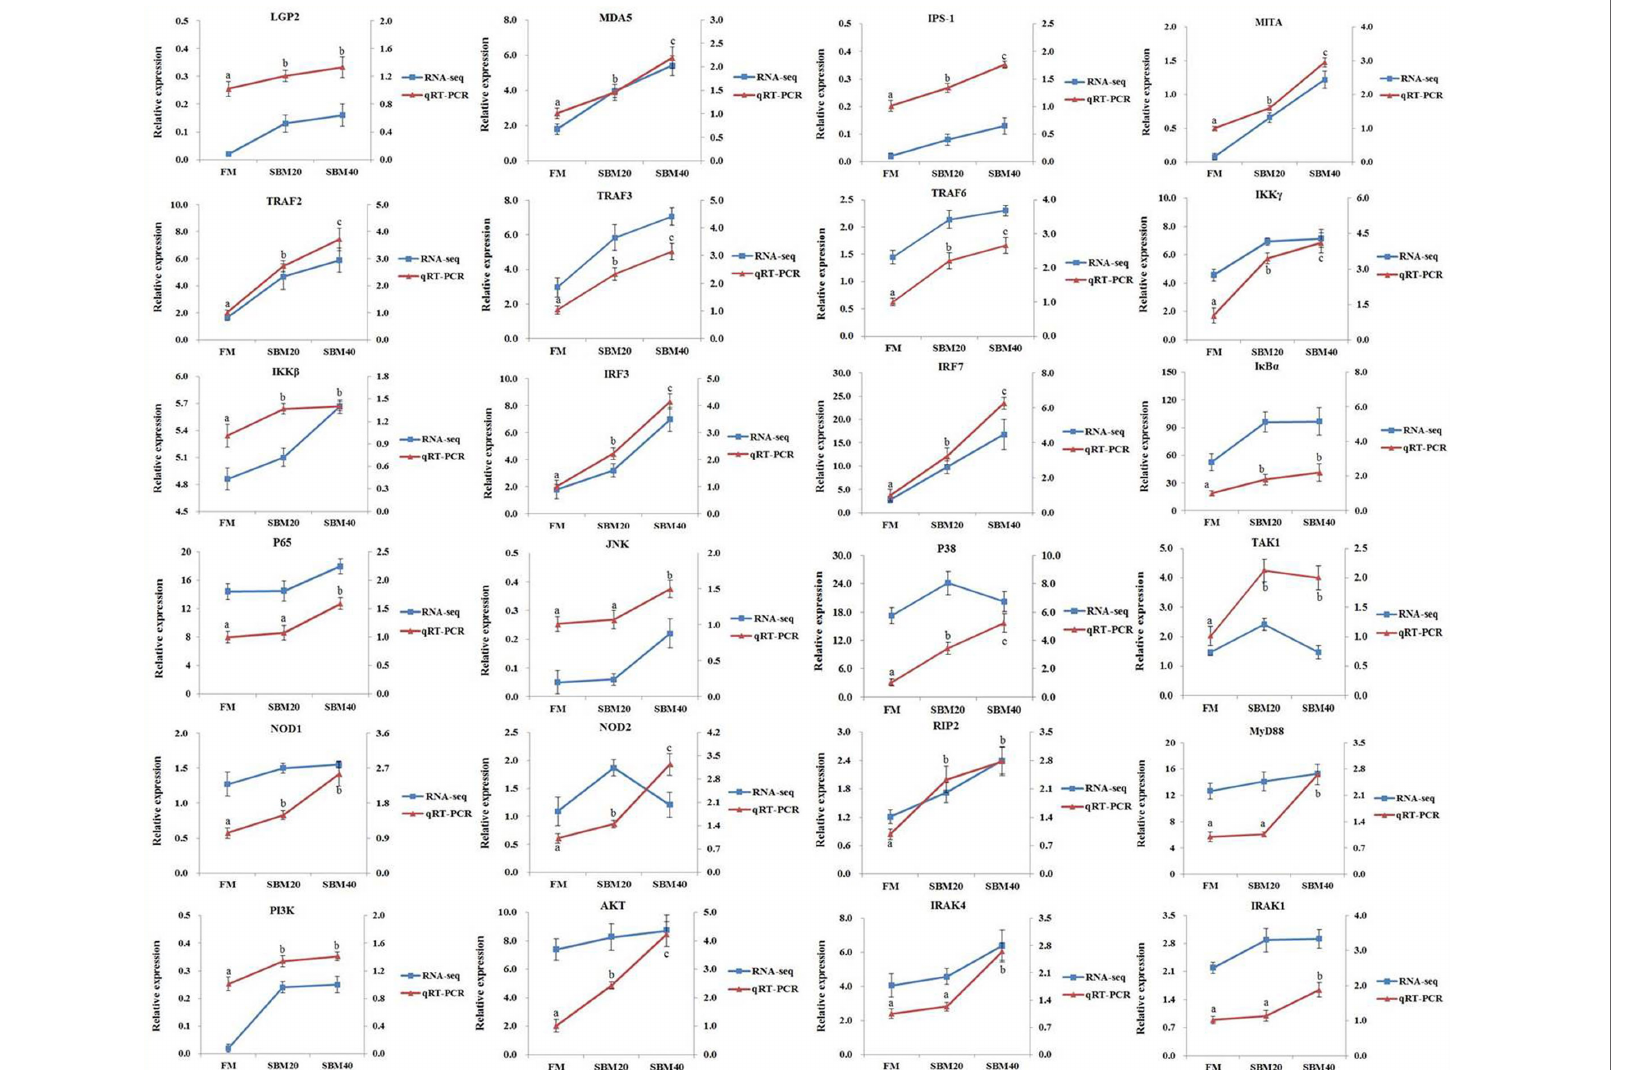
FIGURE 7 | Comparison of transcriptome sequencing and RT-qPCR results ( n = 4). The mRNA expression level of RT-qPCR was normalized by b -actin. The relative expression level in transcriptome sequencing was calculated by the FPKM value. The statistical results are expressed as mean ± SD. Different letters assigned to the lines represented signi fi cant differences between the groups at p < 0.05. FM, fi sh meal control group; SBM20, 20% SBM substitution level to FM; SBM40, 40% SBM substitution level to